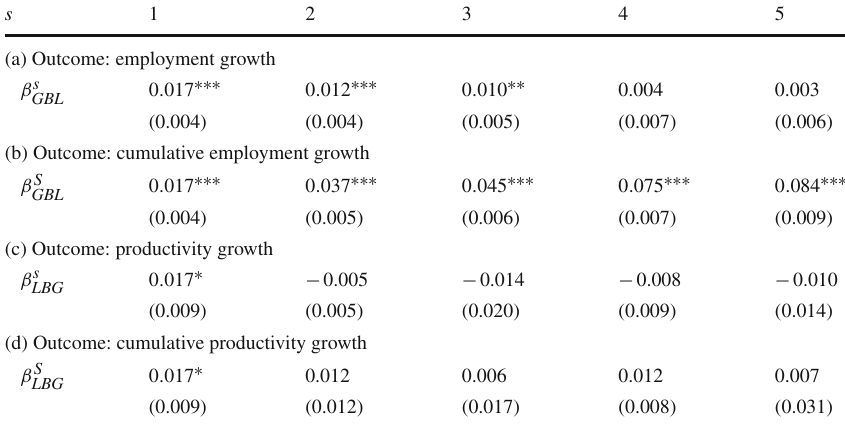
Table 3 Estimated GBL and LBG